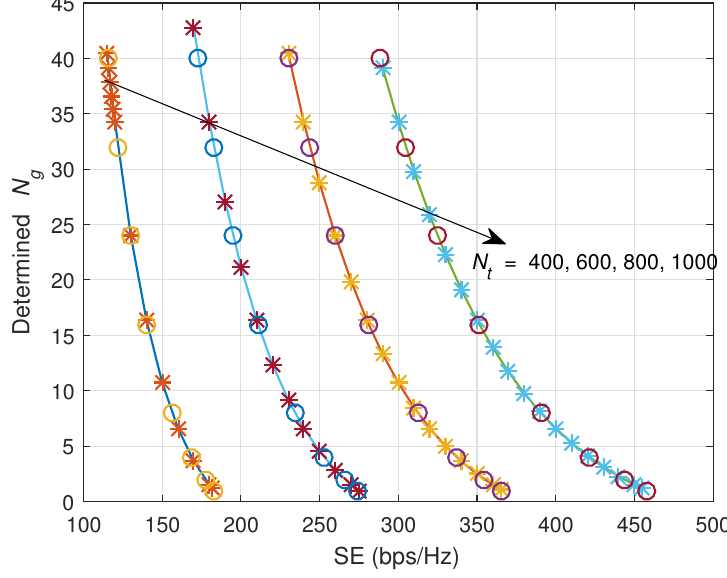
Figure 8. Determined N g versus guaranteed SE (bps/Hz) when ZF precoding is applied. ‘*’ marks indicate the results of closed-form SE equation, and ‘O’ marks indicate results of MC